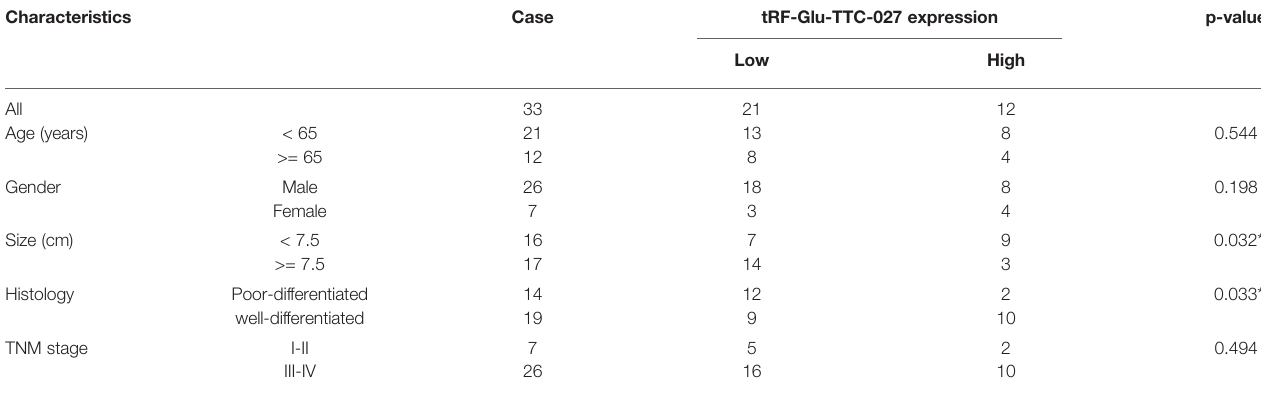
TABLE 3 | Correlations between the expression level of tRF-Glu-TTC-027 and the clinicopathological features in 33 pairs of GC tissues.